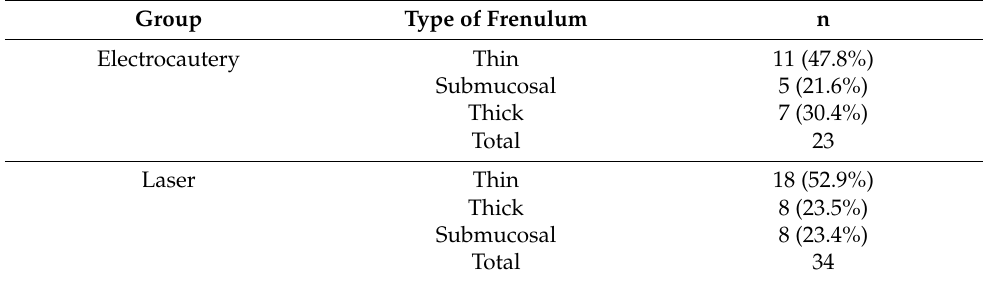
Table 3. Distribution of types of frenulum in different groups.